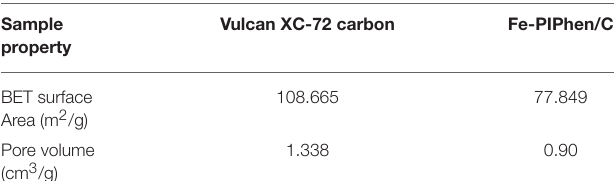
TABLE 1 | The parameters obtained from the nitrogen adsorption/desorption of composite.